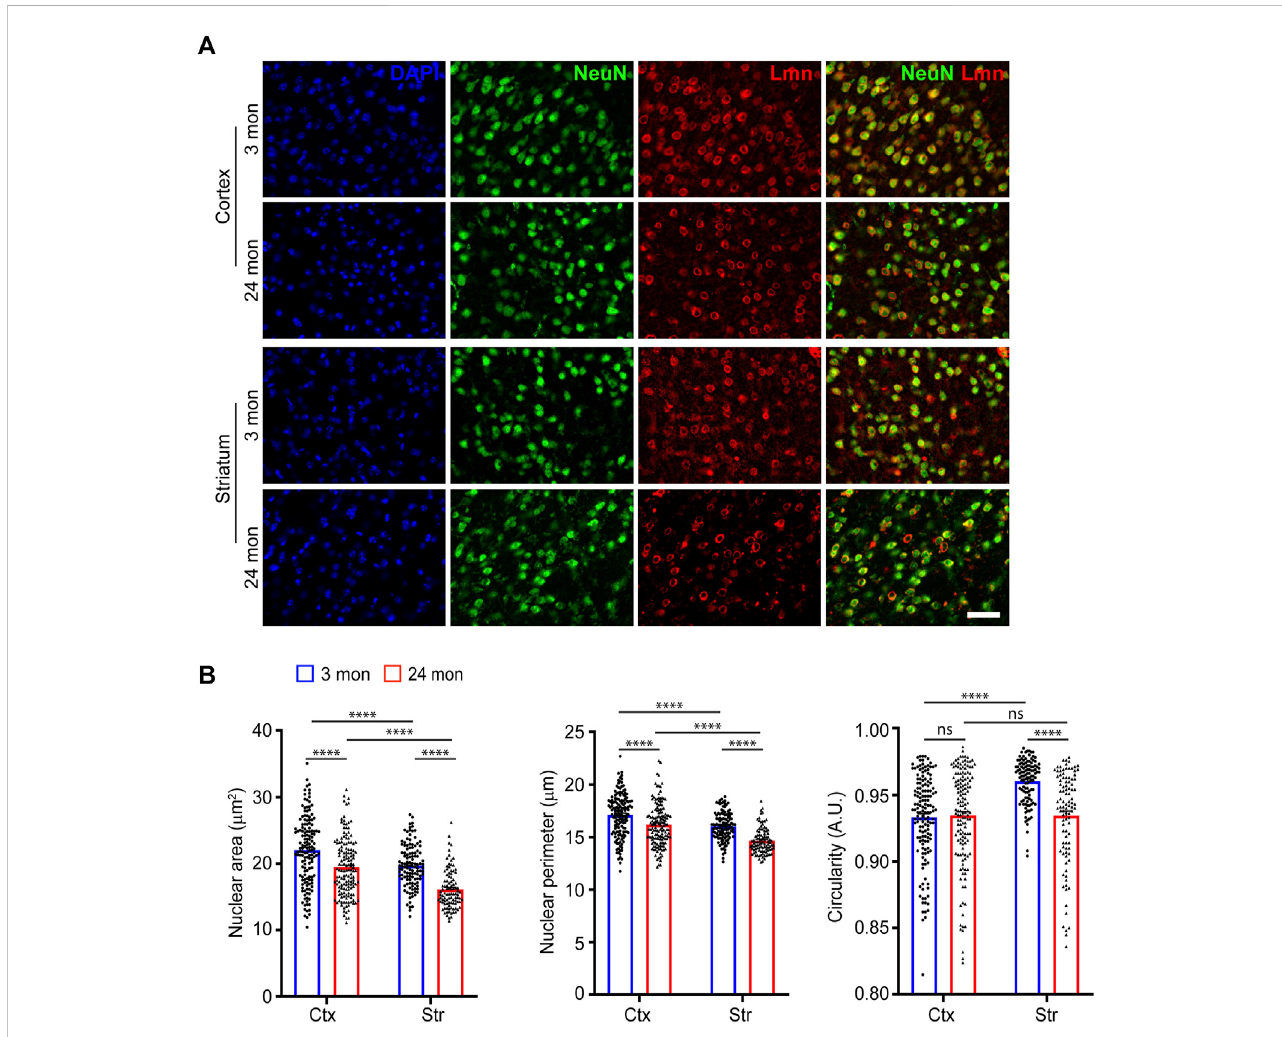
FIGURE 1 Neuronal nuclear morphology in the neocortex and striatum. (A) Immunostaining of brain sections from 3-month and 24-month-old mice using anti- NeuN (green), anti-Lmn (red) along with DAPI (blue) (Scale bar, 20 µm). (B) Mean neuronal nuclear area, perimeter, and circularity in the neocortex (Ctx) and striatum (Str). One-Way ANOVA (* p < 0.05, ** p < 0.01, *** p < 0.001 and **** p < 0.0001). n = 3 mice. Data represented as mean ±